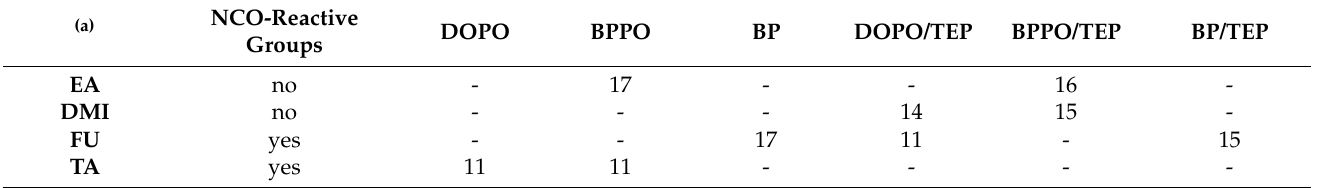
Table 4. Vertical flame spread data of the studied PIR foams with phosphorus-containing FRs and water uptake < 20% (PIR foams without TEP: 0.7 wt.% P; PIR foams plasticized with TEP: 1 wt.% P); flame height is given in cm.